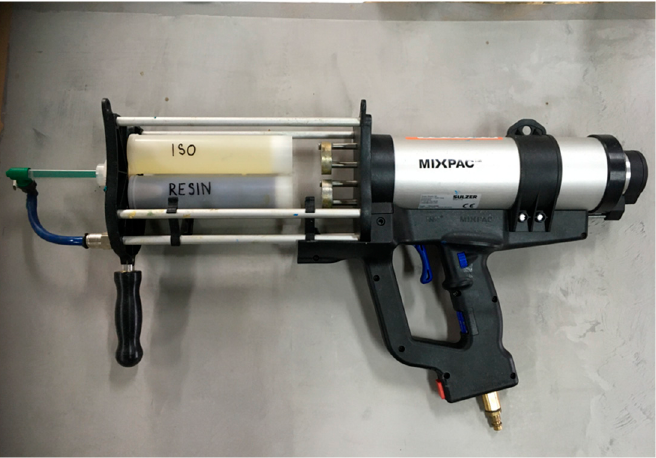
Figure 9 . Pneumatic dispenser equipped with a cartridge and static